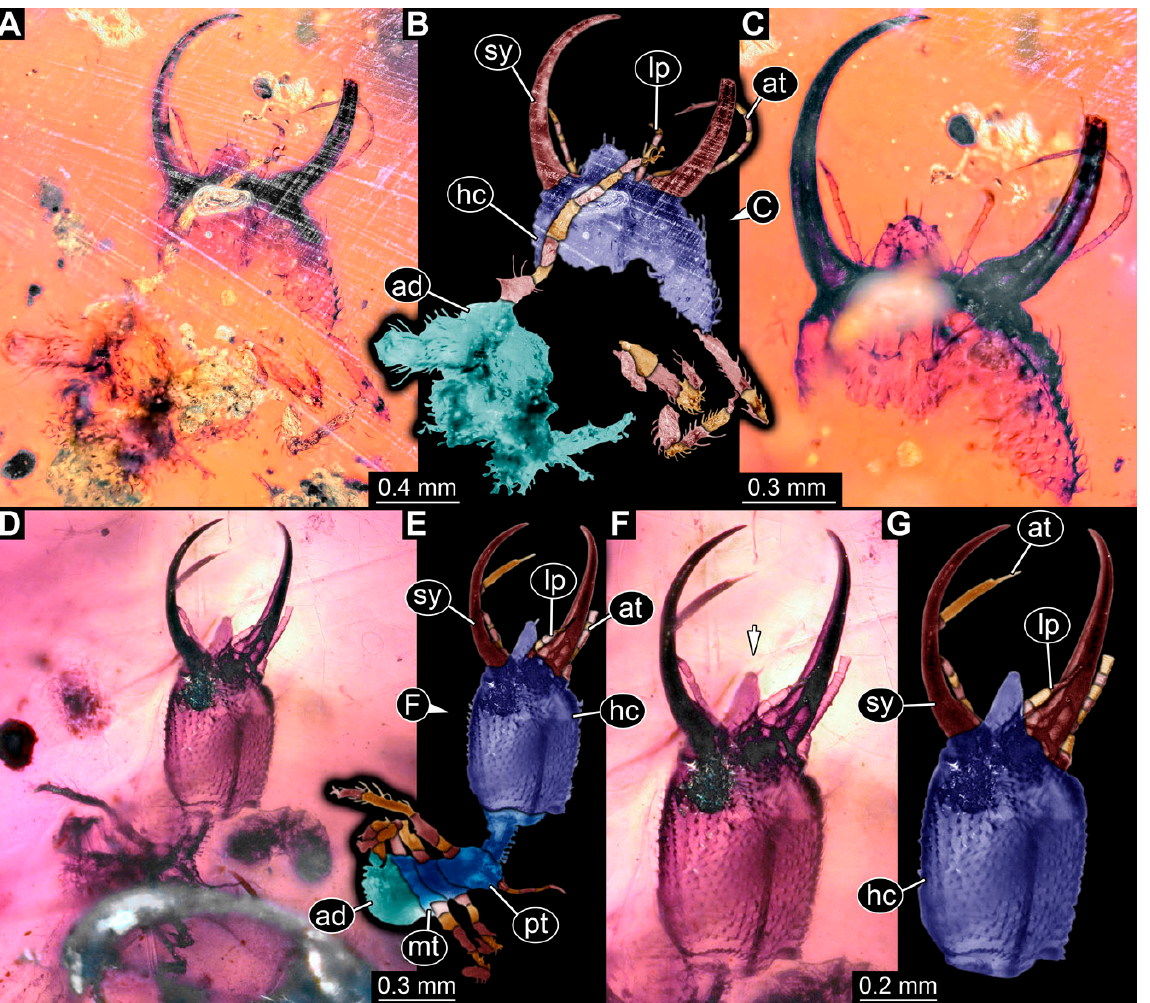
Figure 21. Specimens in Myanmar amber. ( A – C ) Specimen 85 (PED 1887). ( A ) Ventral view. ( B ) Ventral view, colour-marked. ( C ) Close-up of labrum in ventral view. ( D – G ) Specimen 87 (PED 1940). ( D ) Dorsal view. ( E ) Dorsal view, colour-marked. ( F ) Close-up of head; arrow marks labrum. ( G ) Close-up of head, colour-marked. Abbreviations: ad = abdomen; at = antenna; hc = head capsule; lp = labial palp; mt = metathorax; pt = prothorax; sy = stylet. (34) Specimen 86 (PED 1928) is preserved in Cretaceous Myanmar amber (Figure 22).